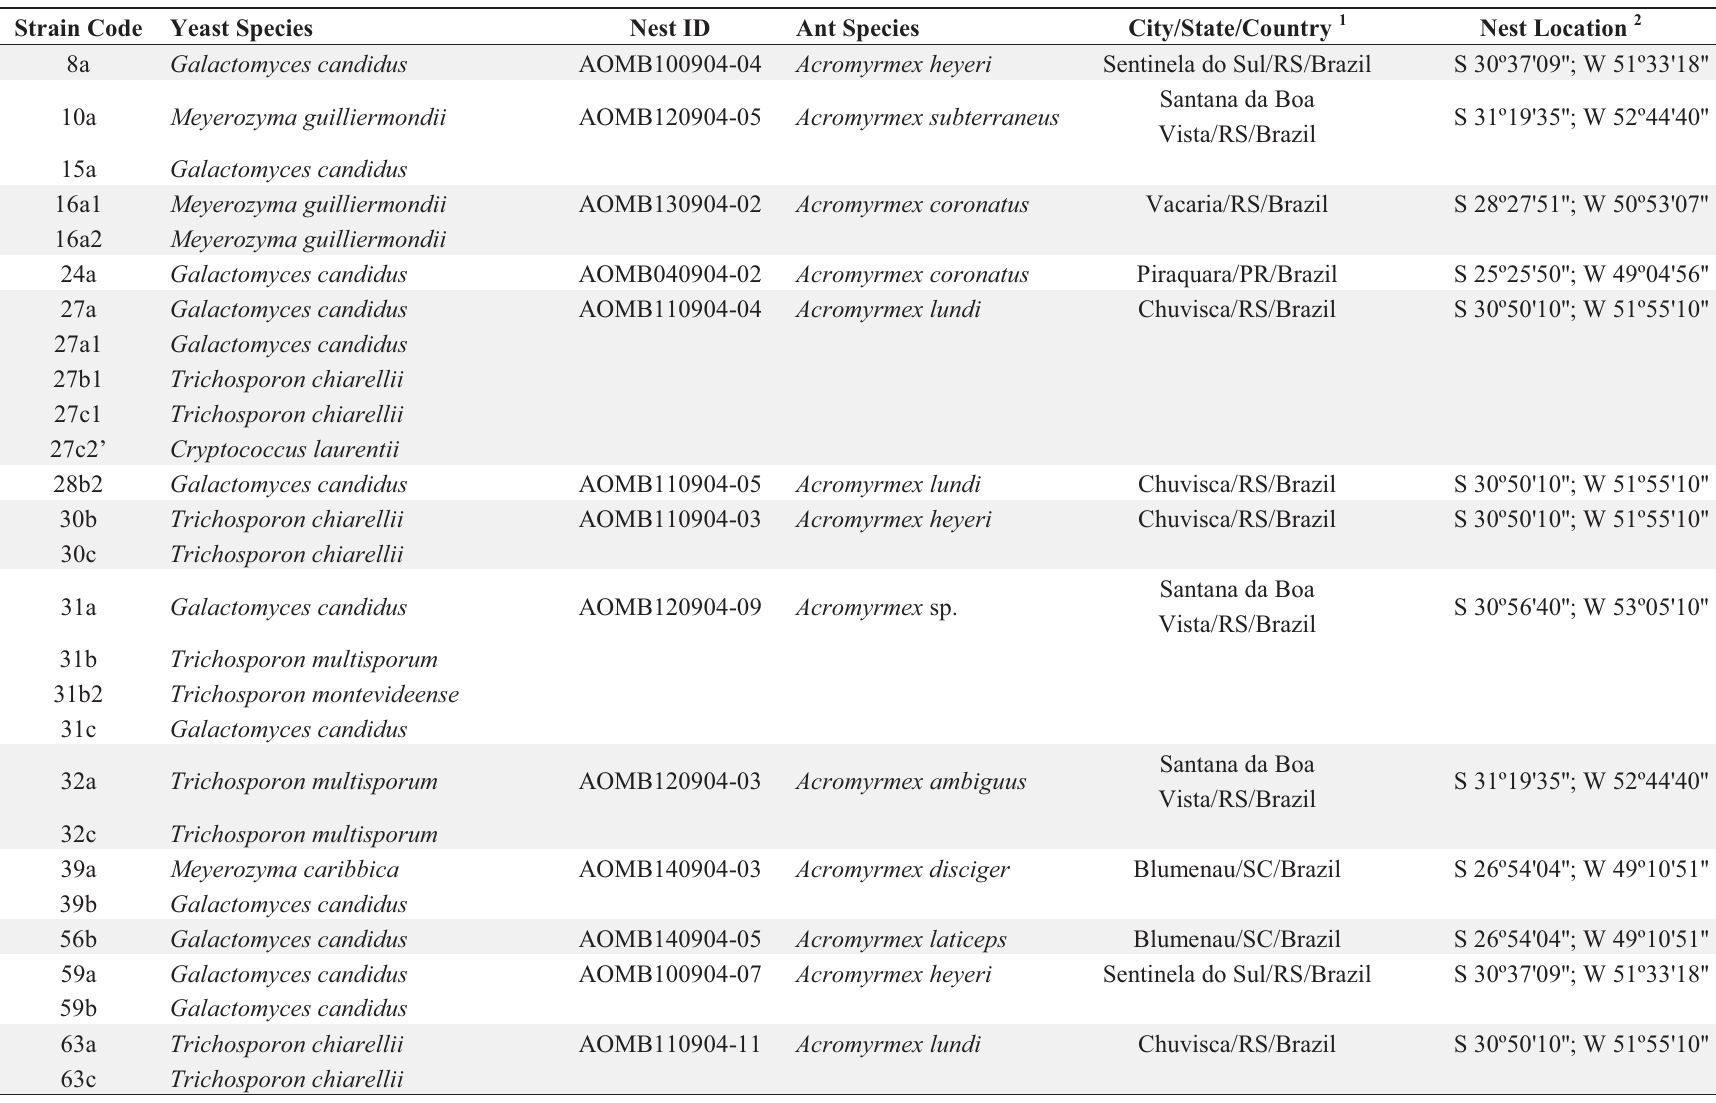
Table S1. Yeast and yeast-like strains